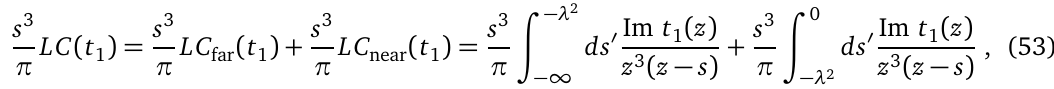
Figure 5: Comparison between the moduli of t channel. The two amplitudes separate around a scale 200 MeV above the two pion